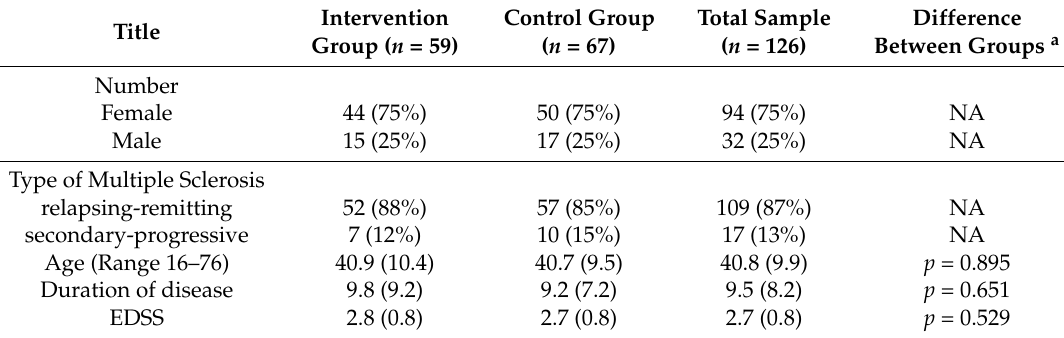
Table 1. Baseline characteristics of the study participants by group (mean (SD) or n (%)).